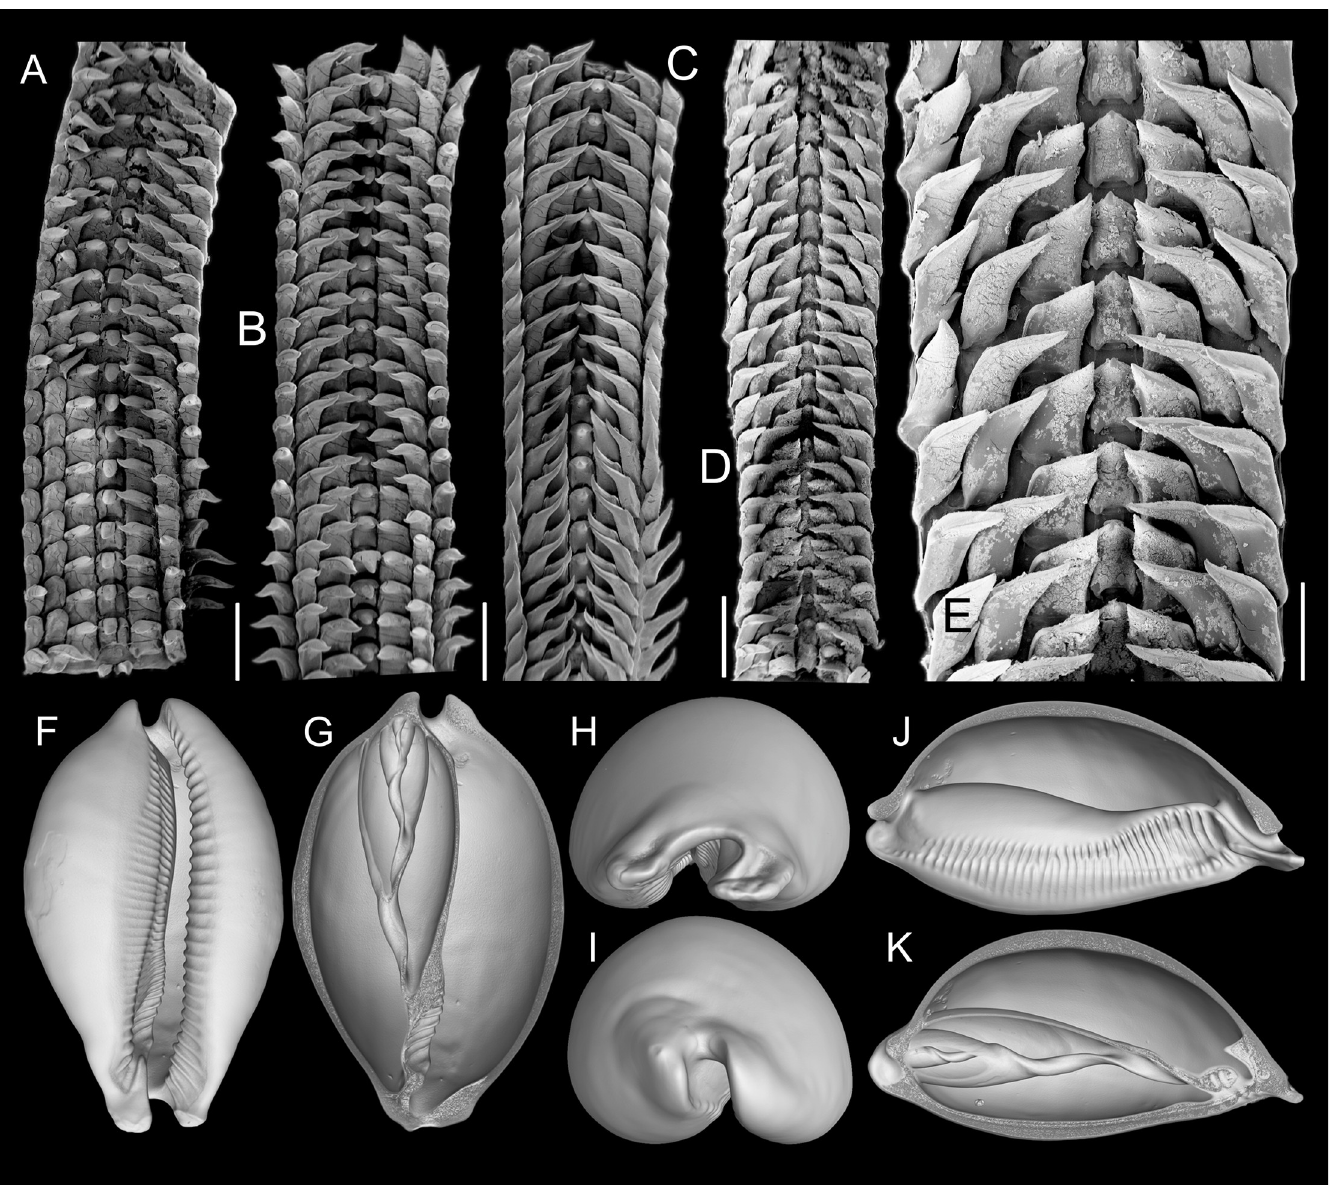
Fig 4. Macrocypraea spp radulae in SEM. (A) M . mammoth paratype MZSP 137546; (B-C) M . mammoth holotype. (D) M . cervus ANSP 93276. (E) Same, detail. scales = 32–35: 1 mm, 36: 0.5 mm. (F-K) M . mammoth MZSP 137545, 3D reconstructions of shell (CT-Scan) (L 100.0 mm). |(F) Frontal view. (G) Same, more ventral portions removed. (H) Anterior view. (I) Posterior view. (J) Right view, right half removed. (K) Same, section along columellar axis. mantle, except for rounded tip bent externally. Osphradium ganglion thick, running along central region of each branch. Distance between osphradium and gill equivalent to osphra- dium width. Gill ( gi ) occupying ~1/3 of pallial cavity roof, long, strongly curved (concavity located to left), surrounding osphradium. Ctenidial vein relatively broad, width homogeneous along its length; connection with auricle sub-terminal (Fig 5B: au ) (described below). Each gill filament tall, triangular, tip long, slender and sharp (Fig 5B). Distance between gill and visceral mass narrow in posterior half, successively far from visceral mass and rectum in anterior half. Hypobranchial gland very developed ( hg ), thick, white; occupying area between gill and